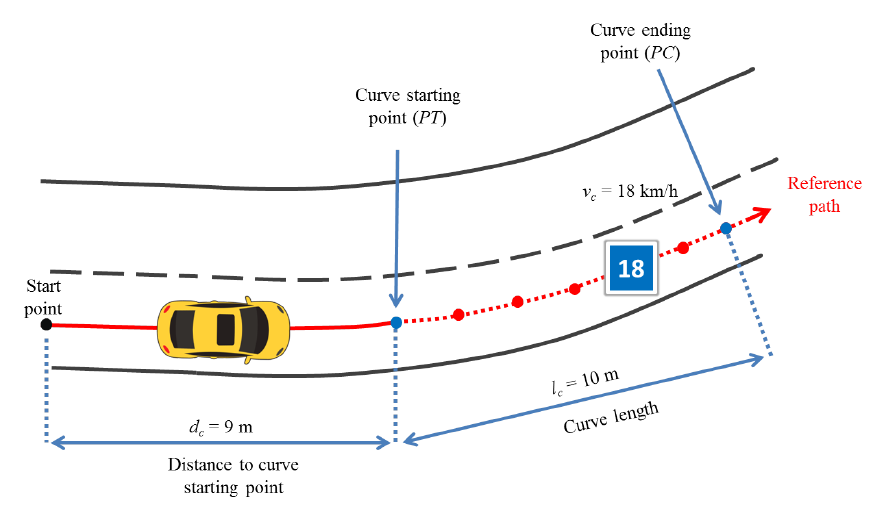
Figure 8. Curve driving scenario.